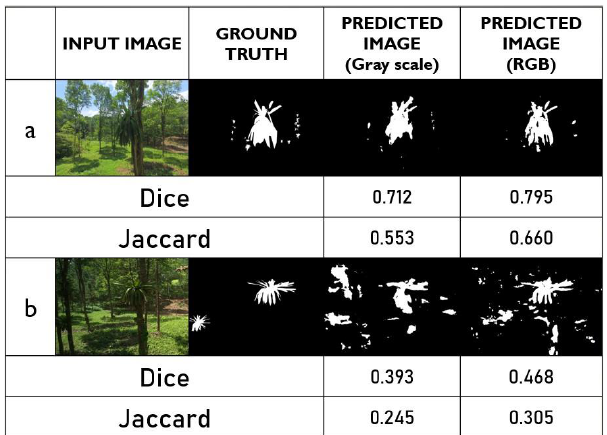
Figure 8: Images that have the target epiphyte under good illumination and high occupancy